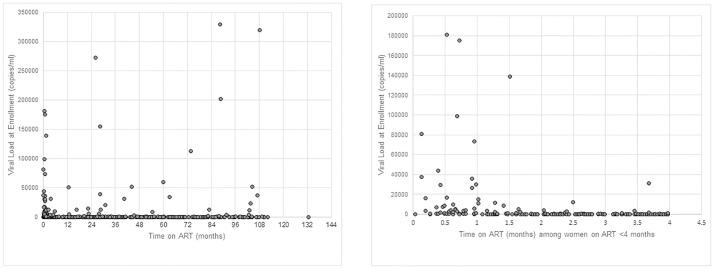
Distribution of viral load results at enrollment by time on ART.(A) Time on ART for all study women with duration and VL information available. (B) Time on ART only for study women on ART < 4 months with VL results available. Both figure parts exclude one woman with an outlying VL result of 900,000 copies/ml and <1 month on ART for ease of viewing.